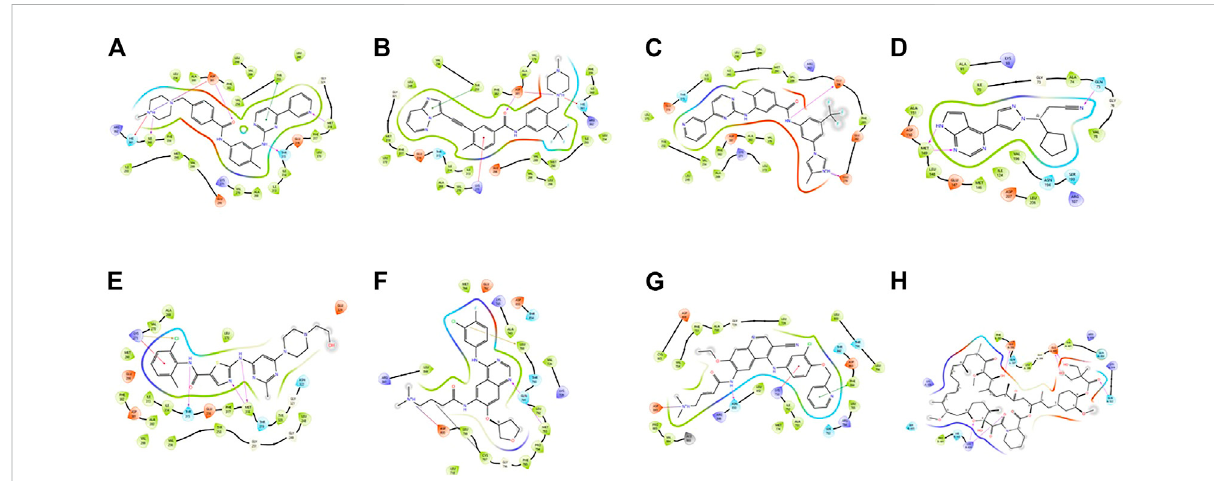
FIGURE 1 Dockingposesofdifferentproteinswithdrugs. (A) Imatinib. (B) Ponatib. (C) Nilotinib dockedtohumanAblkinase(2HYY). (D) Ruxolitinibdockto c-Jun N-terminal kinase (2P33). (E) Dasatinib docked to activated ABL kinase domain (2GQG). (F) Afatinib with EGFR kinase (4G5J). (G) Neratilib docked to HER2(3RCD). (H) Temsirolimus with human serum albumin